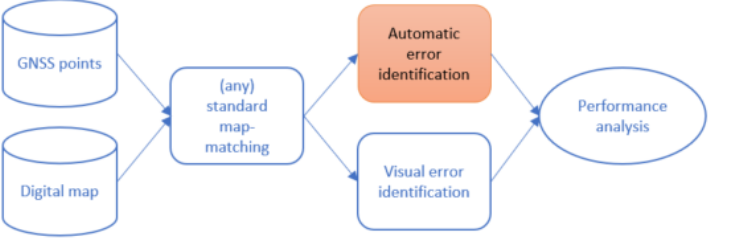
Figure 1. Proposed methodology for map-matching error identification in the absence of ground